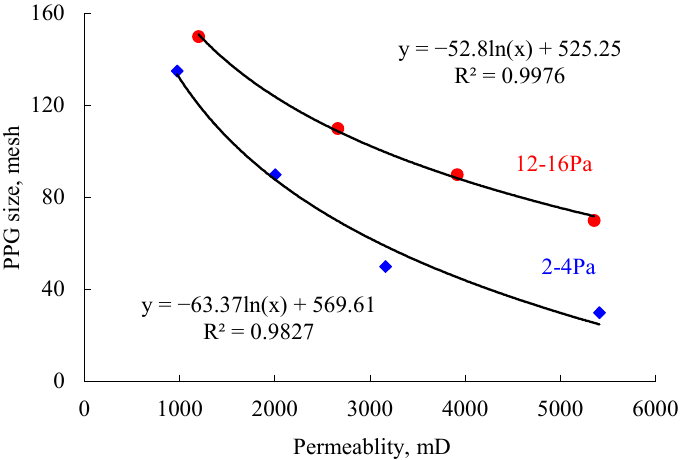
Figure 6. Matching relationships among PPG powder size, elastic modulus and reservoir permea- bility.